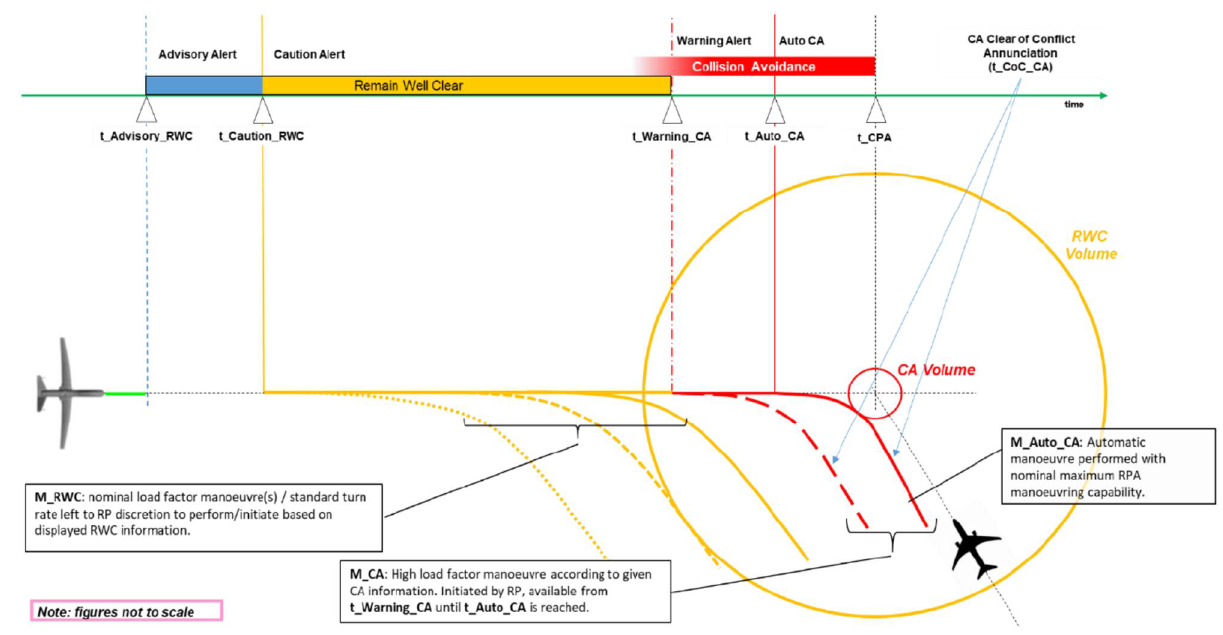
Figure 3. Overall timeline, RWC, and CA concepts